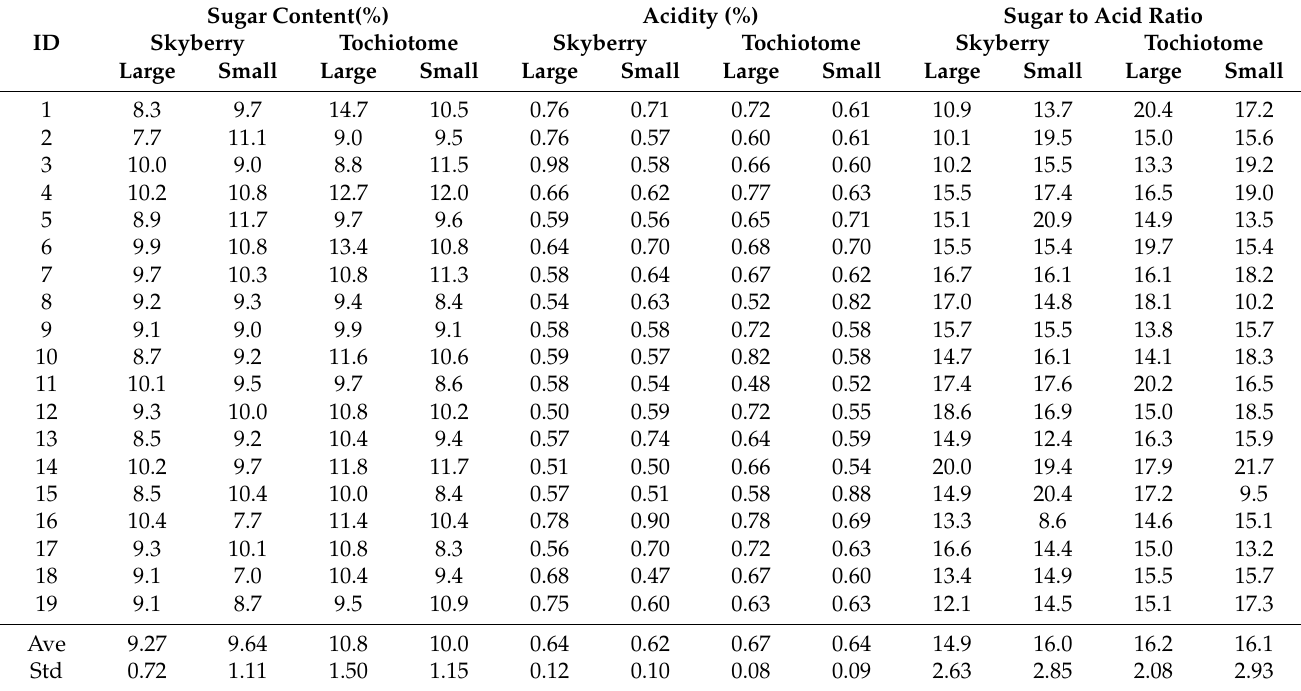
Table 3. Sugar content, acidity, and sugar-to-acid ratio of the